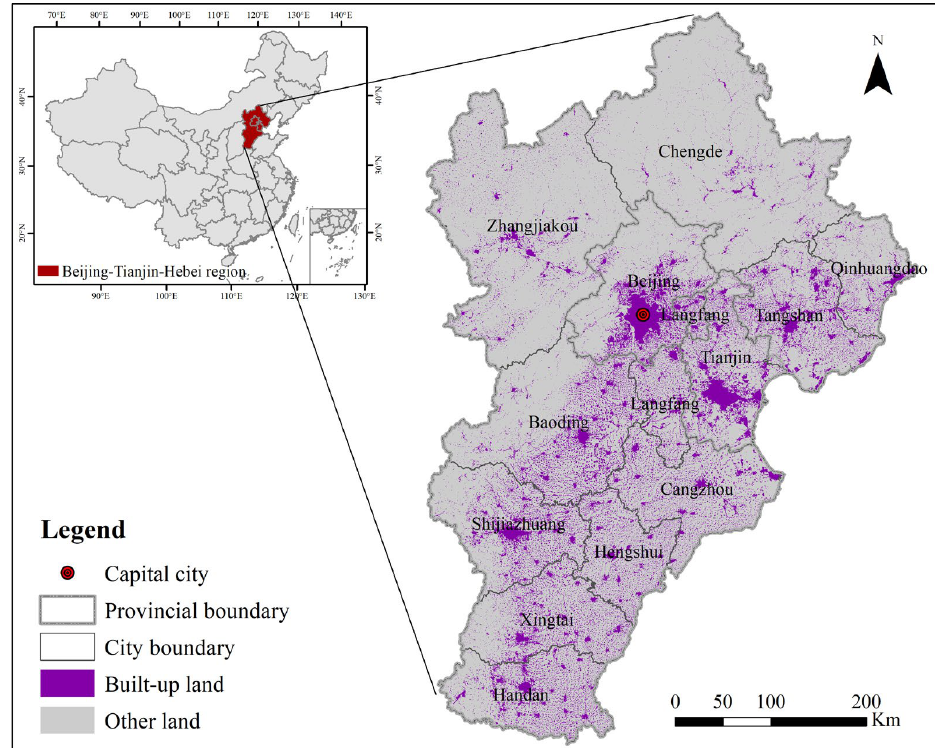
Figure 1. Location, built-up land, and administrative city boundaries of the BTHUA.